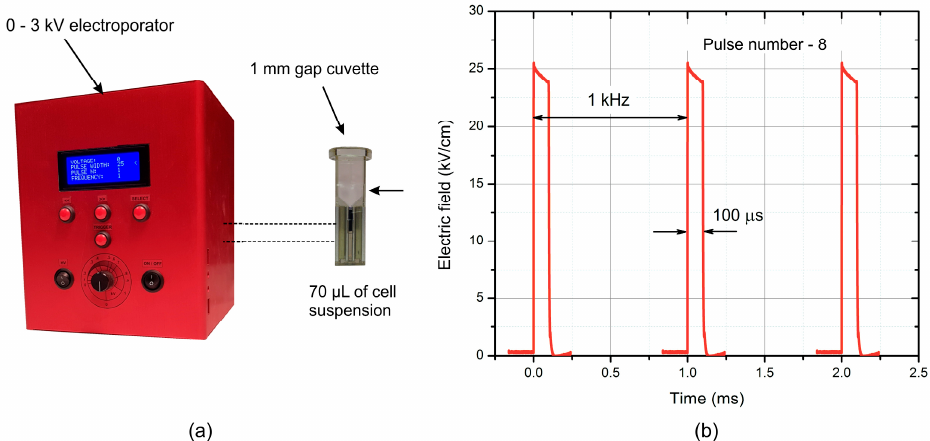
Figure 6. The photo of the setup ( a ) and the waveform of the applied pulses ( b ) that were used for inactivation of S. aureus .